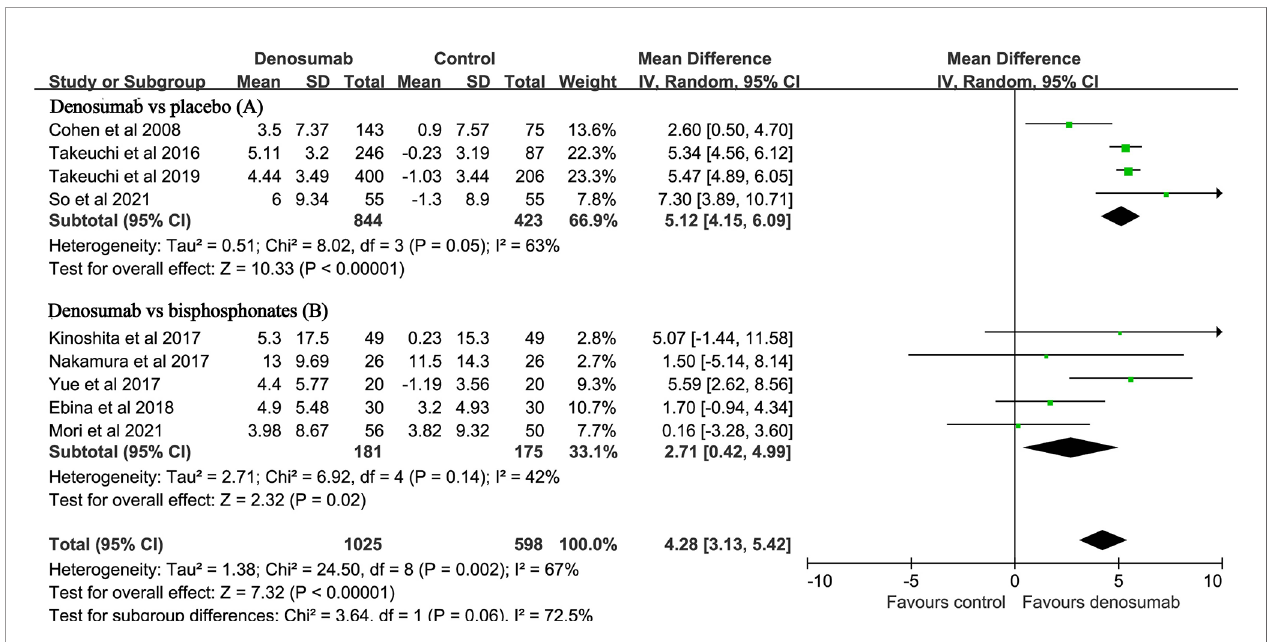
FIGURE 2 | Forest plot for the effect of denosumab on the percent changes in lumbar spine BMD compared with placebo (A) and bisphosphonates (B) .